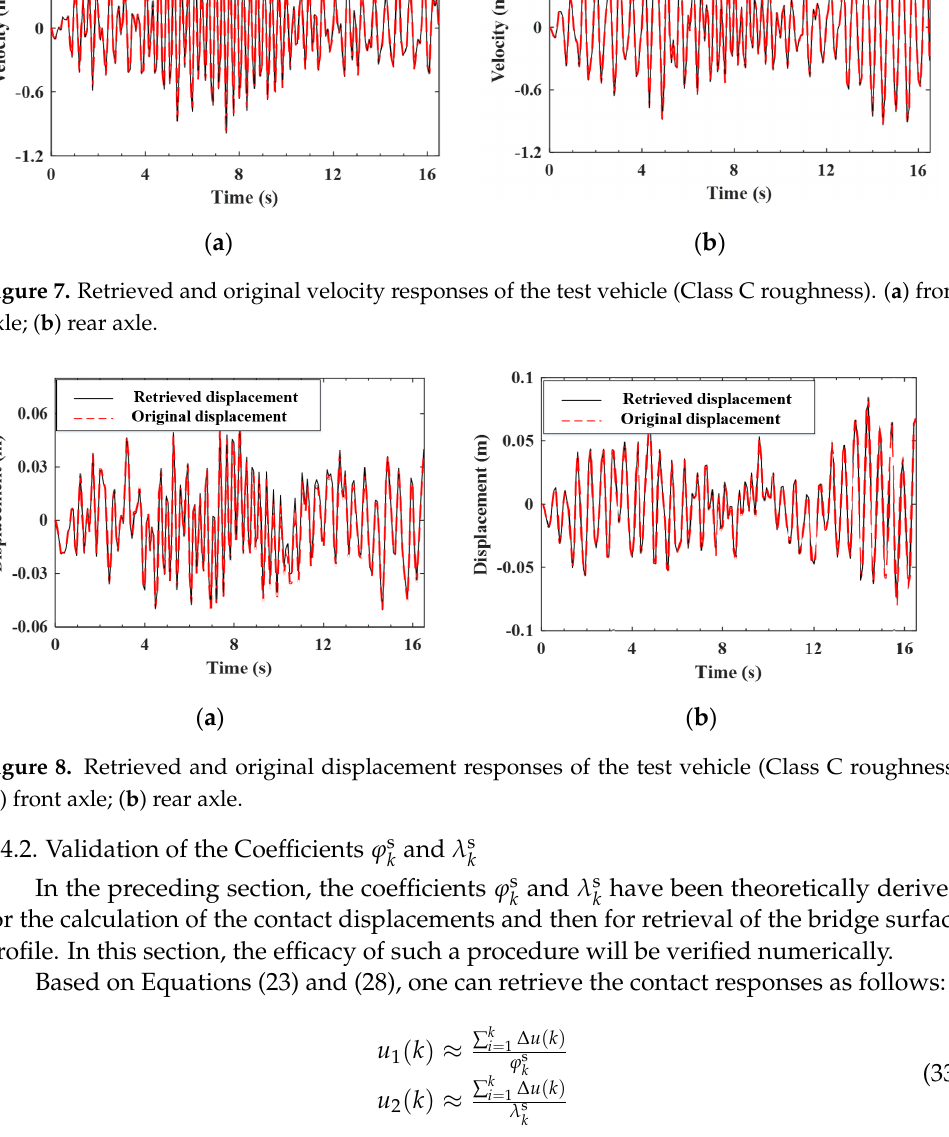
Figure 6. Retrieved and original displacement responses of the test vehicle (Class A roughness). ( a ) front axle; ( b ) rear axle.